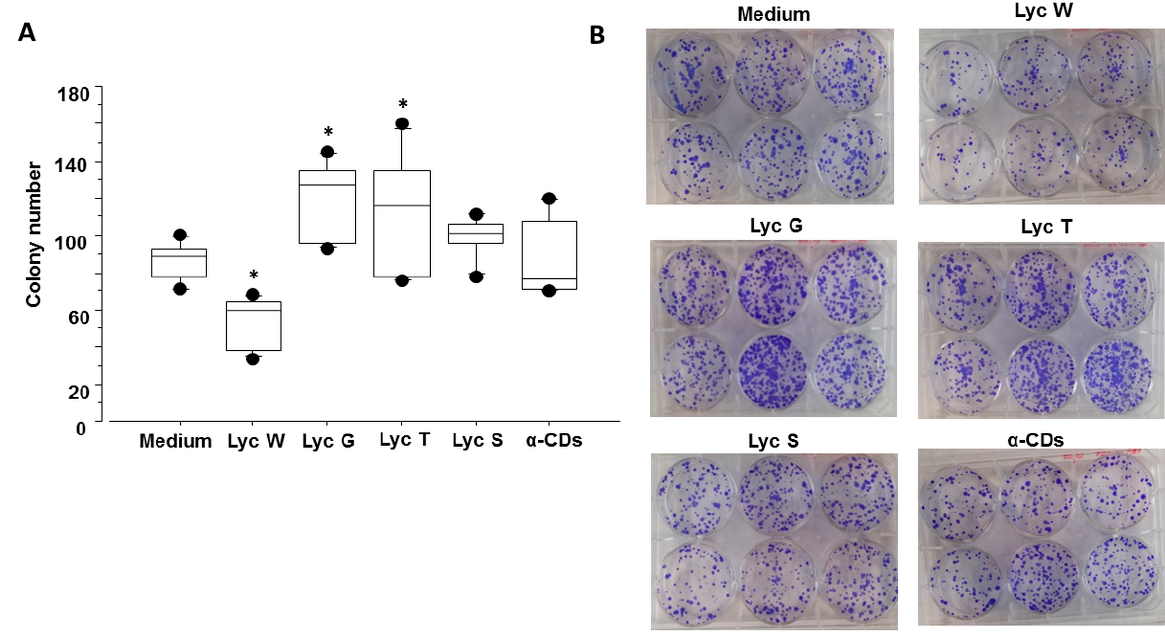
Figure 3. Cell colony assay. Effect of all of the three α -CDs oleoresin extracts on colony formation ability in A549 cell line. ( A ) Lyc W significantly reduced colony numbers whereas Lyc G and Lyc T significantly increased colony numbers when compared to untreated cells. Lyc S treatment was ineffective. The results are shown as box plots with medians (lines inside the boxes). Analysis of variance (ANOVA), Fisher’s PLSD, n = six experiments; *, p -value < 0.05. ( B ) Bright-field pictures of A549 cell colony are